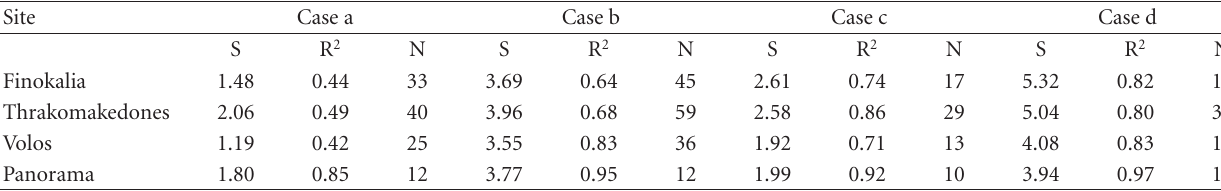
Table 3: Contribution of transported dust to near surface PM10 levels 1